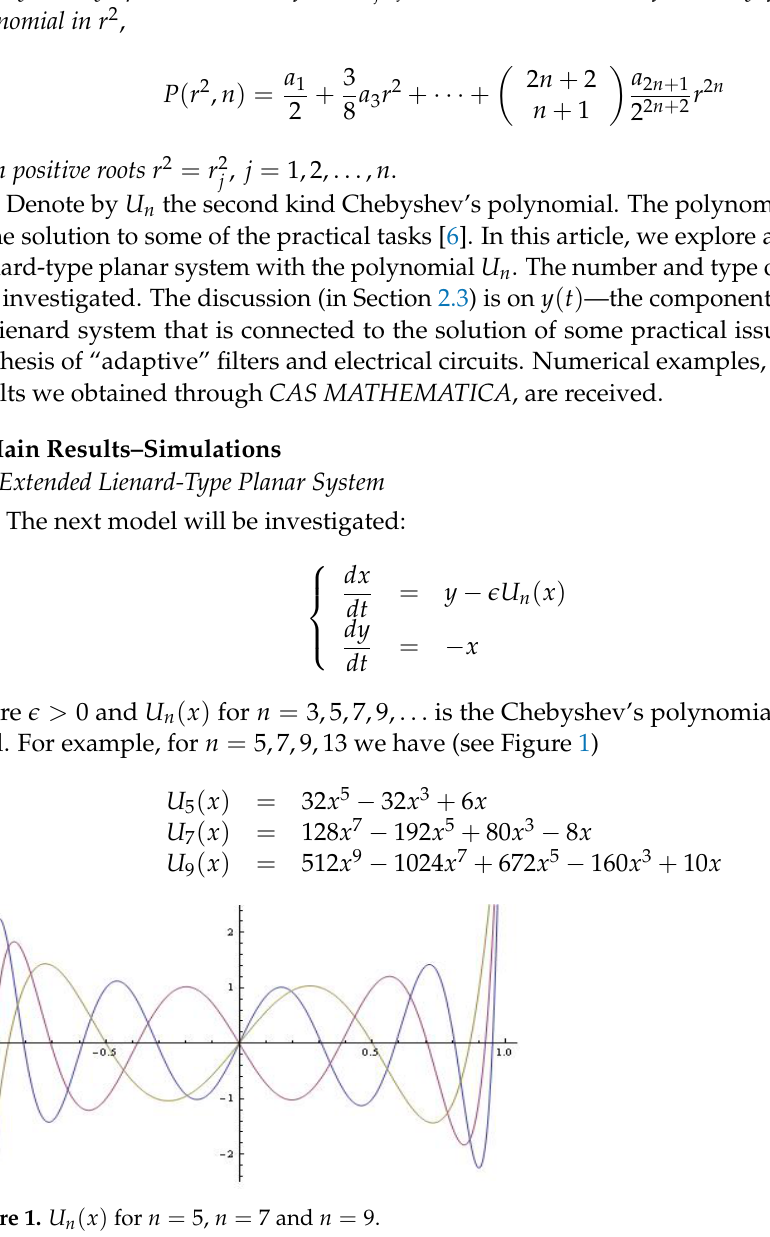
Figure 2. For (cid:101) = 0.001 and n = 5 and x 0 = 0.7, y 0 = 0.3 see Figure 3. The simulation for (cid:101) = 0.006 and n = 7, with the model (5) for x 0 = 0.6, y 0 = 0.4, is shown in Figure 4. For (cid:101) = 0.003 and n = 7; x 0 = 0.5, y 0 = 0.5, see Figure